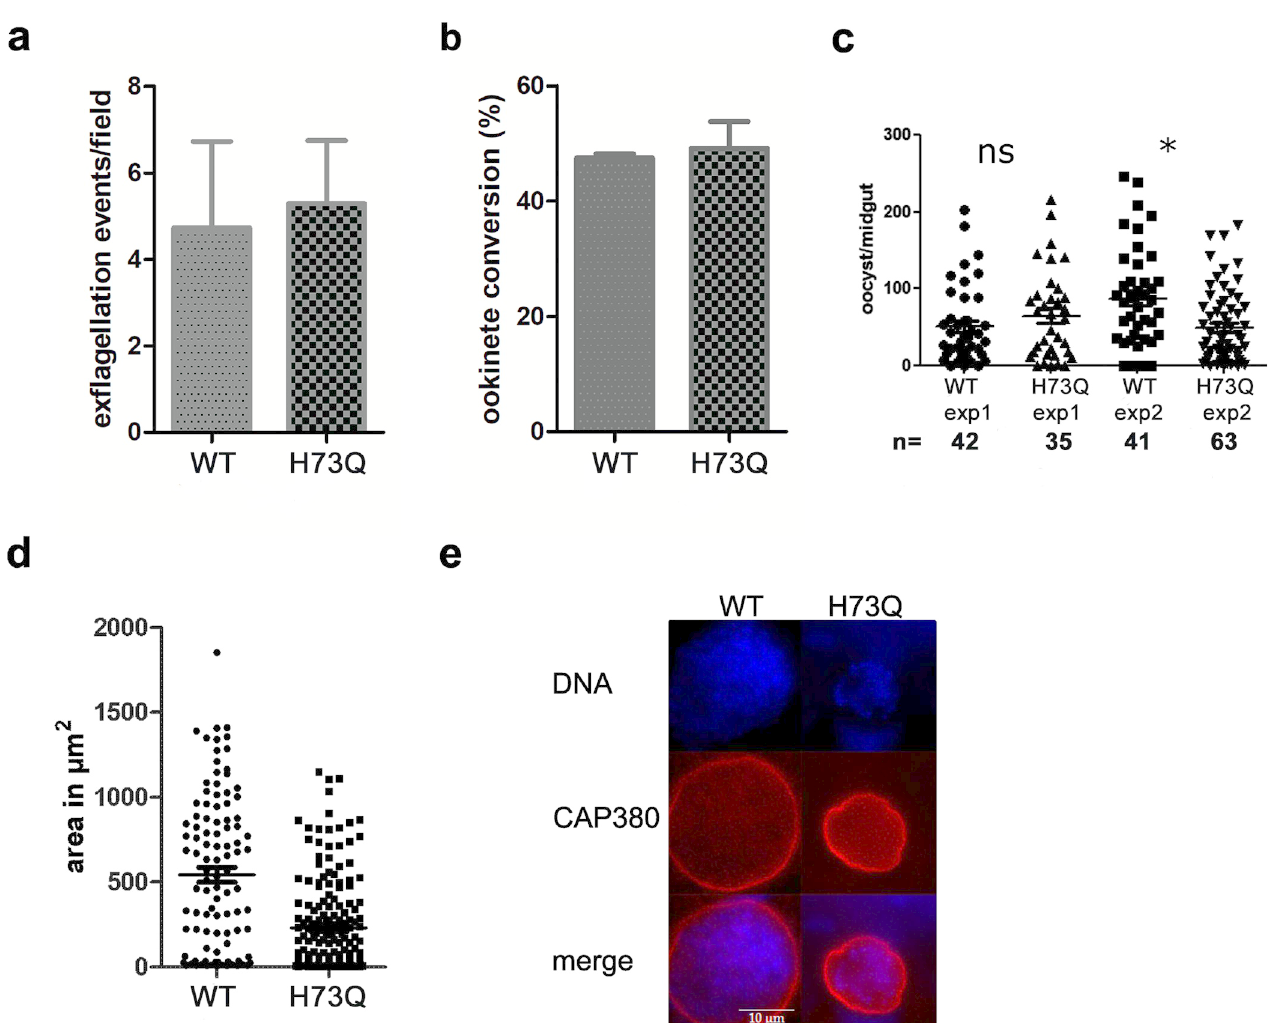
Fig 6. Methylation of actin II is required for oocyst development. (a) Exflagellation of actIIH73Q was comparable to WT. Exflagellation tests were carried out three times for the WT and eleven times for the mutant. Error bar denotes SEM. Differences are not significant (Student’s t-test). (b) Ookinete conversion of the mutant compared to WT determined as the percentage of zygotes that developed into ookinetes. Error bar denotes SEM. Differences are not significant (Student’s t-test). (c) Number of oocysts/midguts from mosquitoes fed with WT or the actIIH73Q mutant. Two independent experiments are shown, number of midguts (n) in each experiment are shown below the graph. The number of oocysts was determined after staining the dissected midguts with the antibody against the Cap380 protein of the oocysts. All labeled oocysts were counted irrespective of size. There was no significant difference comparing WT to mutant, Mann-Whitney test. (d) Area in μ m 2 of WT and actIIH73Q oocysts. The area of 106 WT and 180 mutant oocysts from the experiment in (c) were measured in Image J. Differences are statistically significant p < 0.0001 Student’s t-test. (e) Representative oocysts of WT and actIIH73Q mutant. Oocysts were labeled with Cap380 and DNA stained with Hoechst 33342. Raw data related to panels a-d can be found in S2 Data. mutant were offered to A . gambiae female mosquitoes. After 12–13 days, midguts were dis- sected and labeled for the oocyst capsule protein Cap380, and DNA was stained. All oocysts were counted, even those that were small, and this revealed only a minor decrease in the num- ber of oocysts in the actIIH73Q strain comparing to the WT ( Fig 6C ). However, the mutant oocysts were significantly smaller than the WT ( Fig 6D and 6E) . In addition, 80% of WT oocysts contained DNA, while only 42% of the mutant oocysts had visible DNA staining. In the mutant oocysts, no sporozoites were formed. To investigate this further, we allowed infected mosquitoes to feed on na ï ve mice. Giemsa-stained blood samples were observed from day five onwards. This revealed that, while in the WT strain infection was detectable at day five